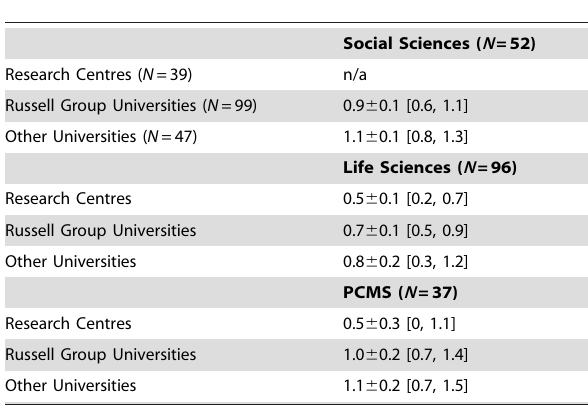
Table 1. PDR’s research output according to research area and research institution: mean 6 standard error and 95% confidence interval (brackets).